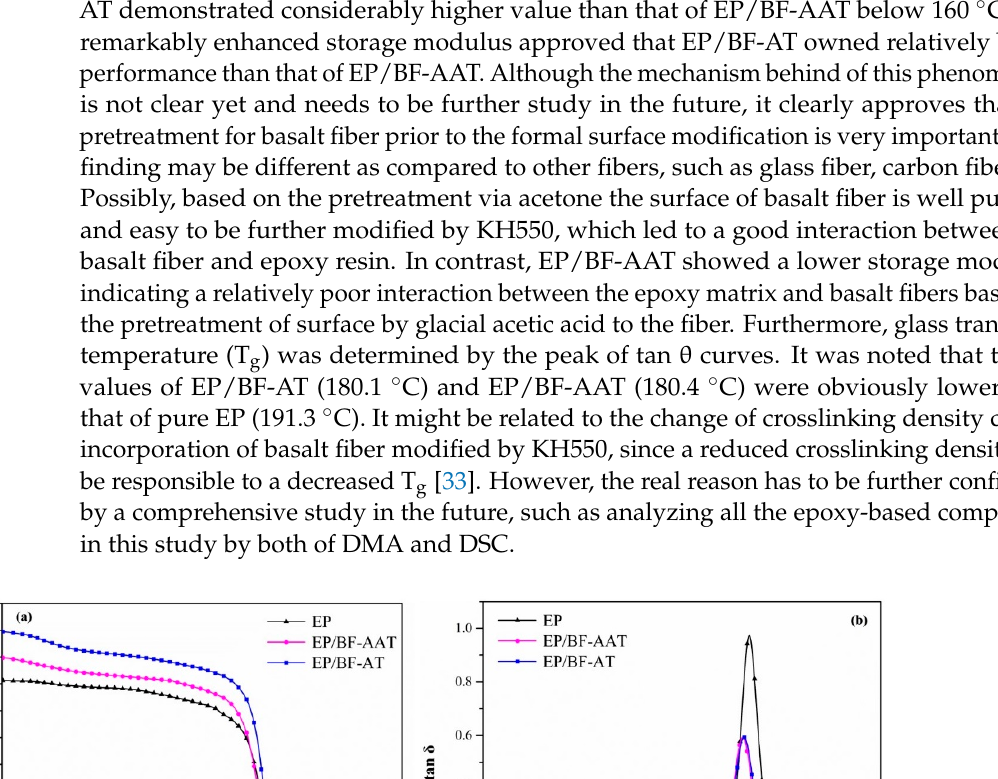
Table 2. Data obtained from TG and DTG curves of EP, EP/AP750, and